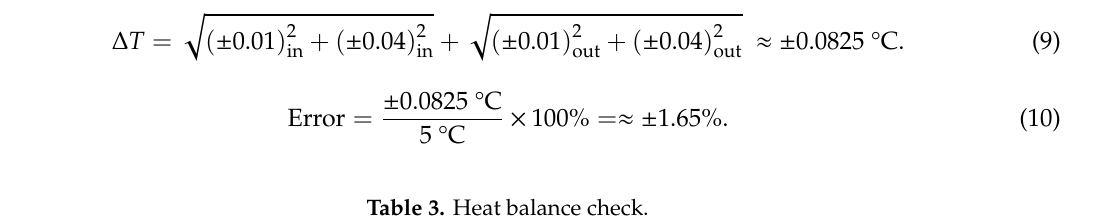
Table 3. Heat balance